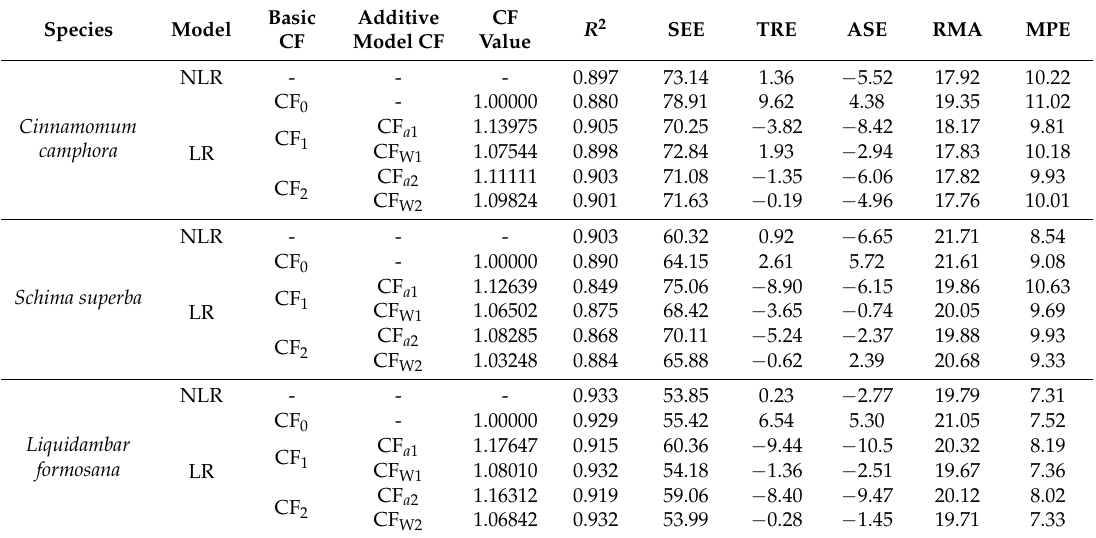
Table 4. Evaluation statistics of aboveground biomass applying different correction factors for three tree